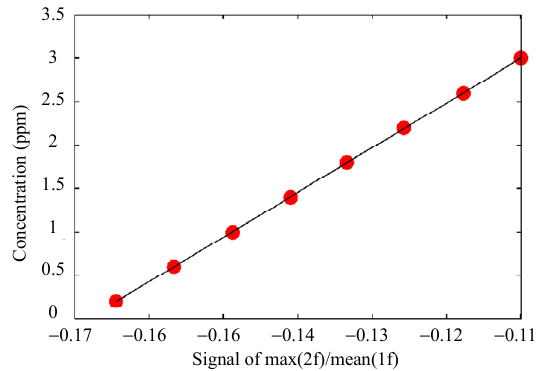
Fig. 5 Actual concentration points and fitting curves of concentration levels versus